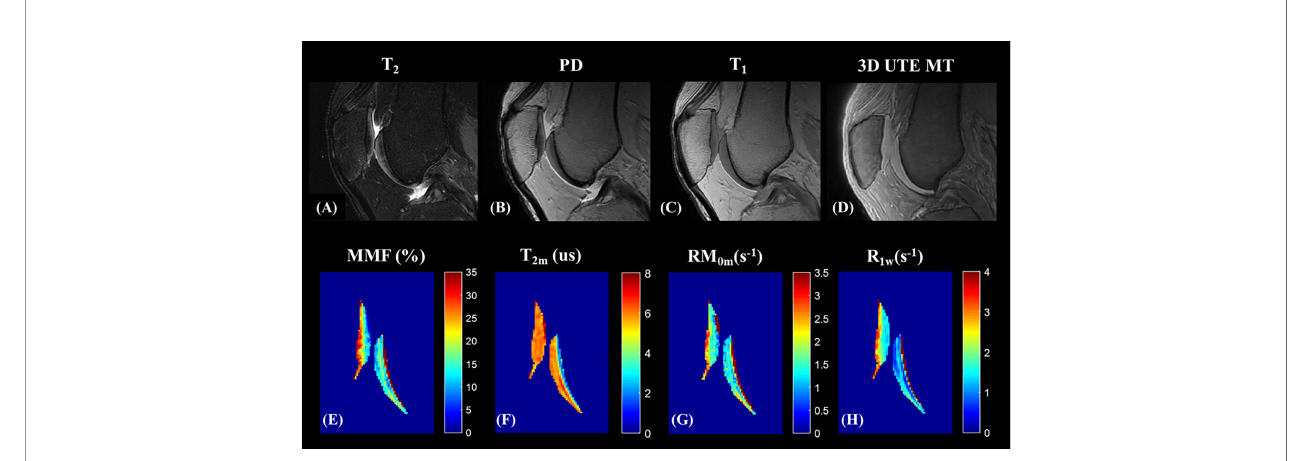
FIGURE 12 | UTE-MT modeling (mapping) of knee cartilage. Panels (A – D) show the representative ex vivo knee MR images acquired from clinical sequences (A – C) and 3D UTE -MT (MT fl ip angle of 500° and frequency offset of 50 KHz) (D) . Color mapping of UTE-MT modeling parameters, including MMF (%) (E) , T 2 relaxation time of the macromolecular pool (T 2m , us) (F) , proton exchange rate from water to macromolecular pool (RM 0m , s -1 ) (G) , and spin-lattice relaxation rate of the water pool (R 1w ,s -1 ) (H) are